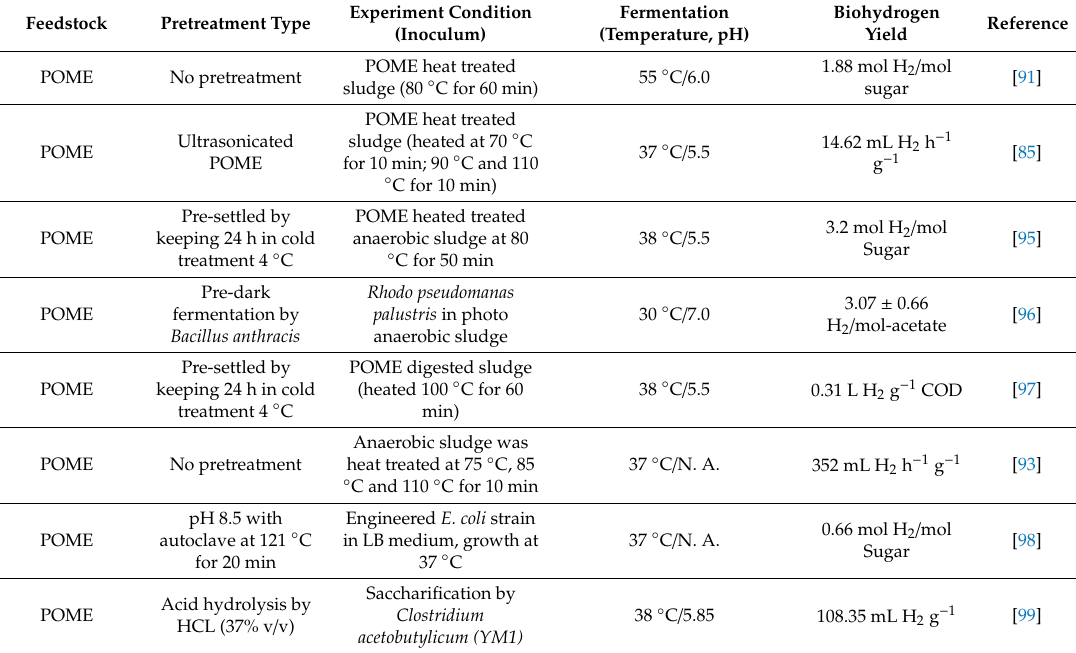
Table 4. Recent studies of hydrogen production from di ff erent sources of oil palm biomass.